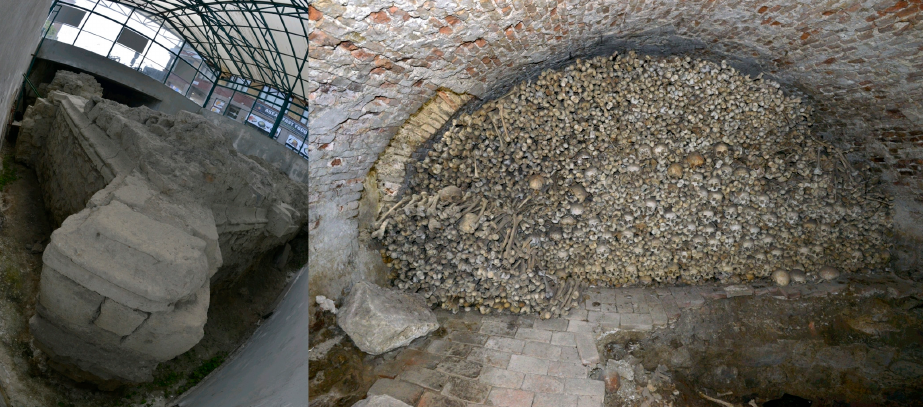
Figure 1. Ruins of St James’s Chapel under the covering structure ( left ), and the ossuary in the basement ( right ).